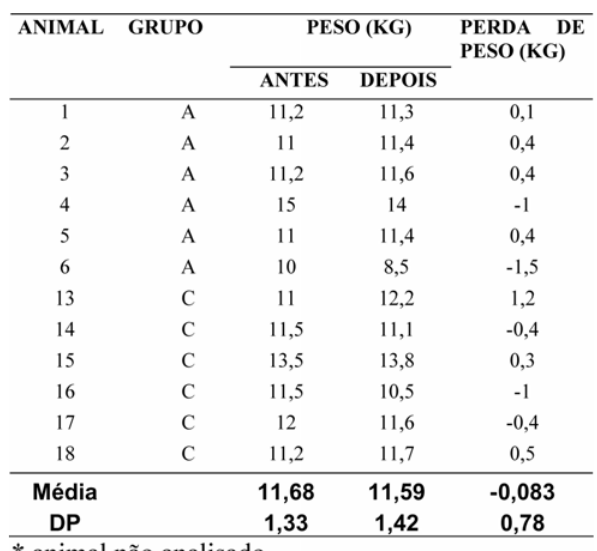
TABELA 1: Resultados da variável perda de peso referente aos animais submetidos à sutura simples da lesão duodenal (Tratamento